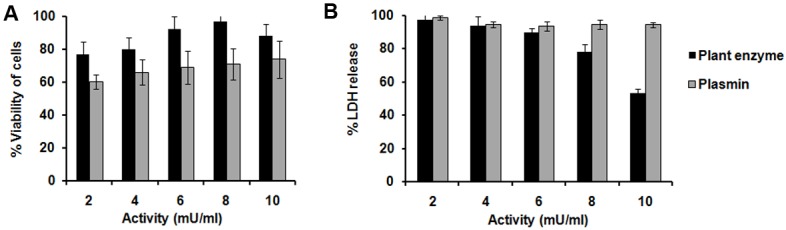
Reduction of co-aggregate induced cytotoxicity by the plant enzymes.
(A) MTT assay: viability of cells was plotted against the concentration of plant enzyme (black bar) and plasmin (gray bar). The viability of the untreated cells was considered as 100%. (B) LDH assay. The % of LDH released from cells was plotted against the concentration of plant enzyme (black bar) and plasmin (gray bar). LDH released from the co-aggregate treated cells was considered as 100%. The values of the untreated cells were subtracted from the test samples. The bars represent mean ± S.D. of five independent experiments in each set. Probability values of p < 0.05 were considered to represent significant differences. The probability values (p > 0.05) of viability and % LDH release from cells treated with co-aggregate were compared with cells treated with co-aggregates preincubated with plasmin. Insignificant difference between these two groups was observed.